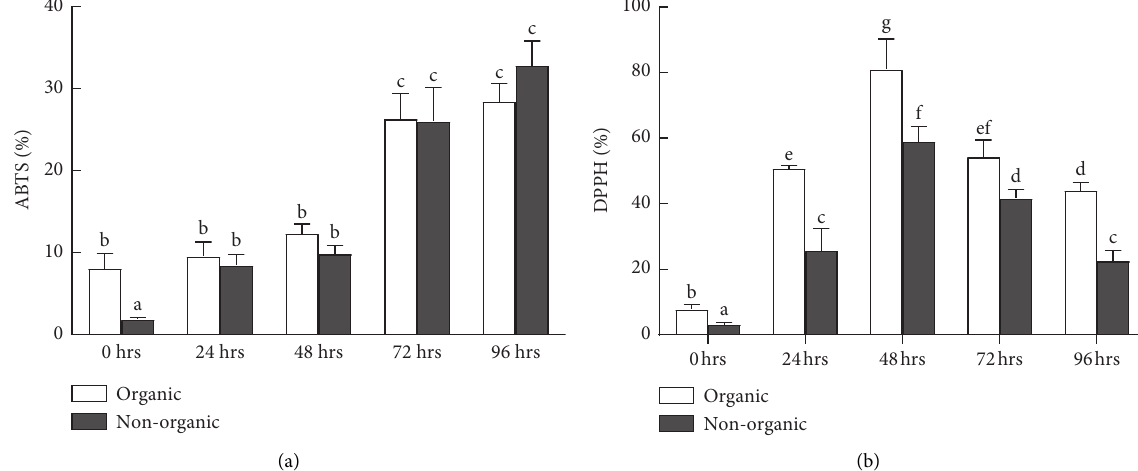
Figure 2: DPPH and ABTS activities of organic and nonorganic vegetable soups at 0h, 24h, 48h, 72 h, and 96h. (a) Change in ABTS radical-scavenging activities. (b) Change in DPPH radical scavenging activity. Each data point is the mean of triplicated data with ± SE. The bars represented with different letters are significantly different from each other at p � 0 . 05 as evaluated by